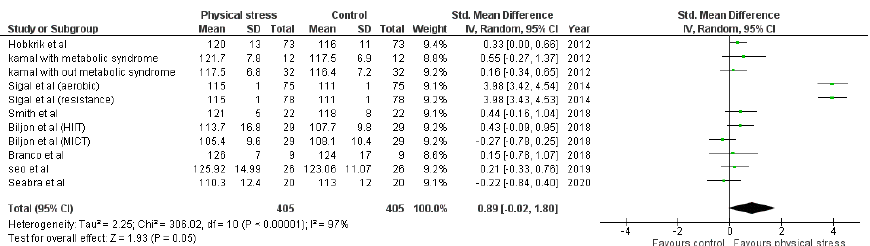
Figure 4. Forest plot showing the results for DBP.